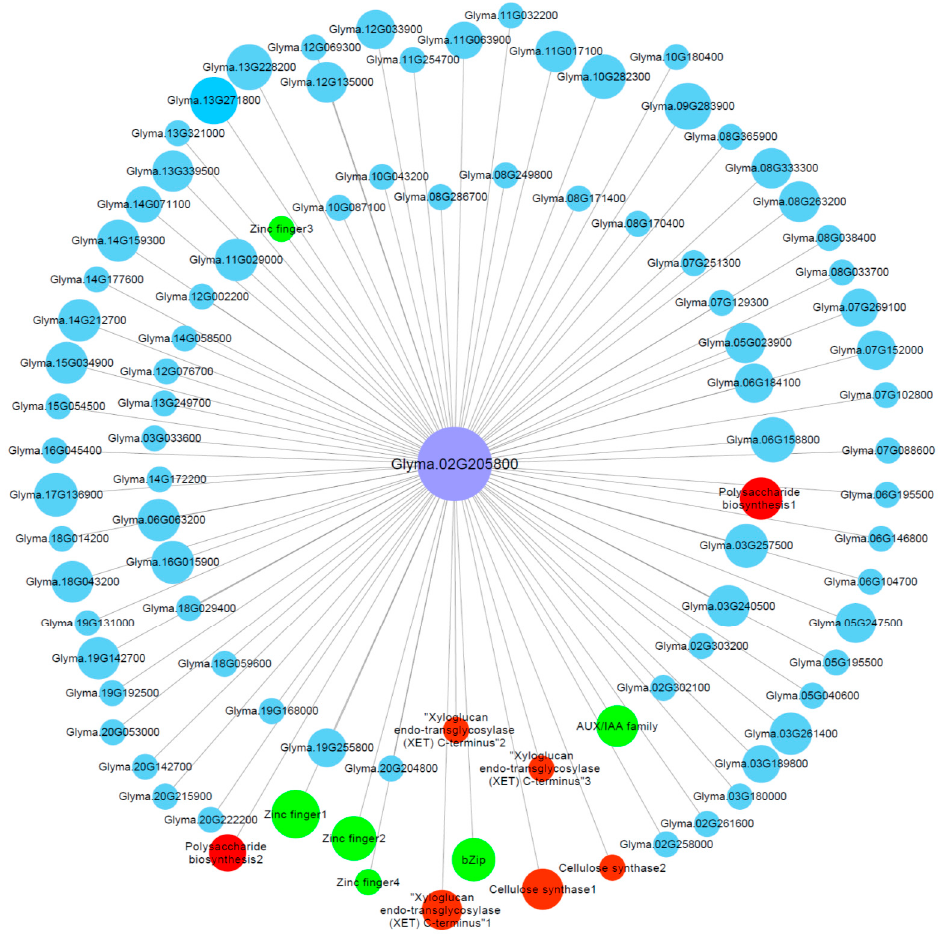
Figure 6. Gene co-expression network for Glyma.02G205800 (encoding cellulose synthase) in the green module. Only the genes (nodes) with the module membership value greater than 0.3 are shown. The nodes in red represent cell wall related genes, while the nodes in green represent known Al-tolerance related genes.